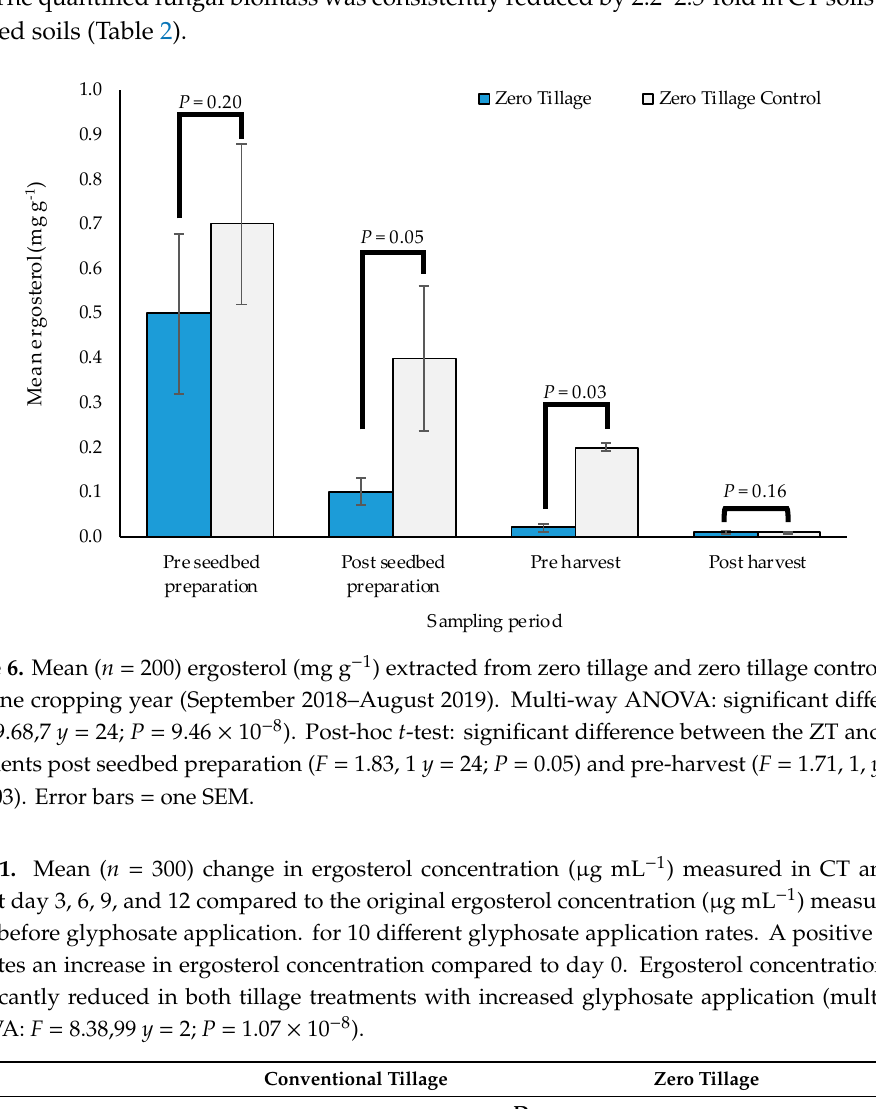
significant reductions with all glyphosate applications of 10g L − 1 and above (post-hoc t- test: F = 1.71,19 y =2; P = 0.02). The quantified fungal biomass was consistently reduced by 2.2–2.5-fold in CT soils compared to ZT treated soils (Table 2).